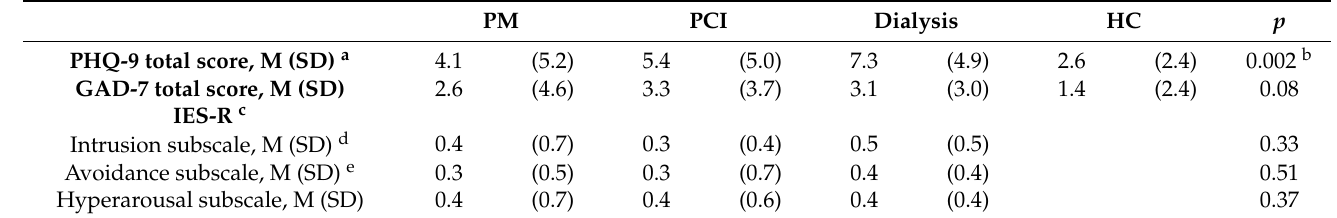
Table 2. Self-report of symptoms of depression, anxiety, and posttraumatic stress (measured by PHQ-9, GAD-7 and IES-R, respectively) according to study group.